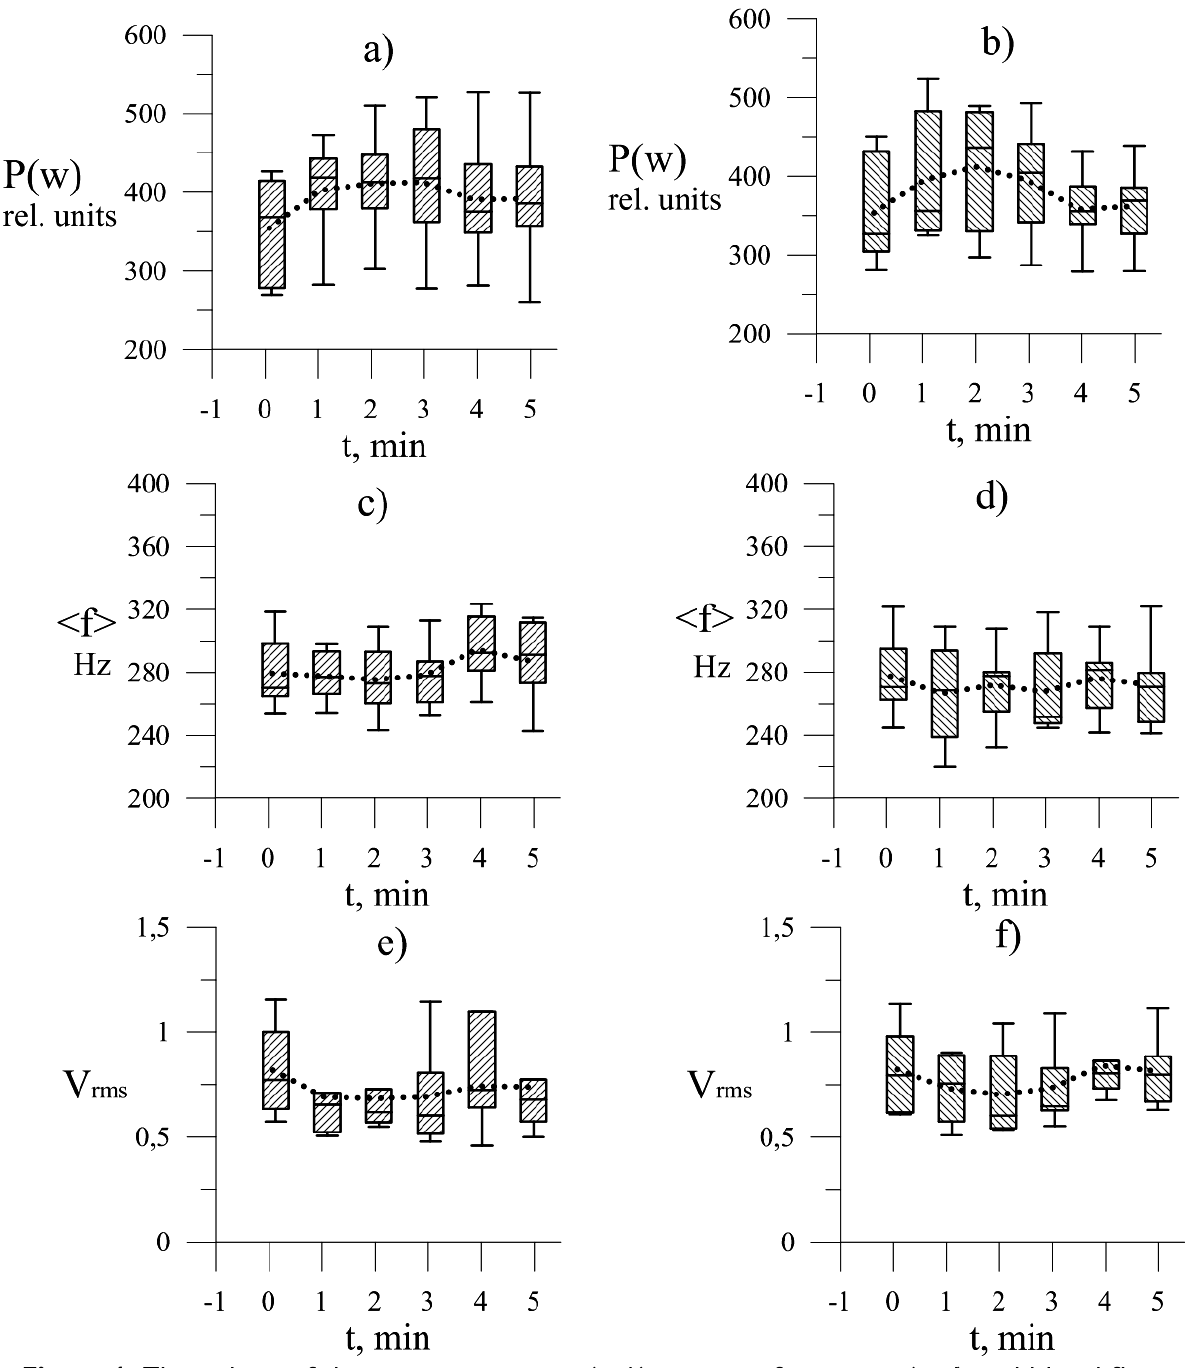
Figure 1. The values of the spectrum power ( a, b ), average frequency ( c, d ) and blood flow velocity ( e, f ) measured by the Speckle-Scan device: a, c, e - left hand; b, d, f - right